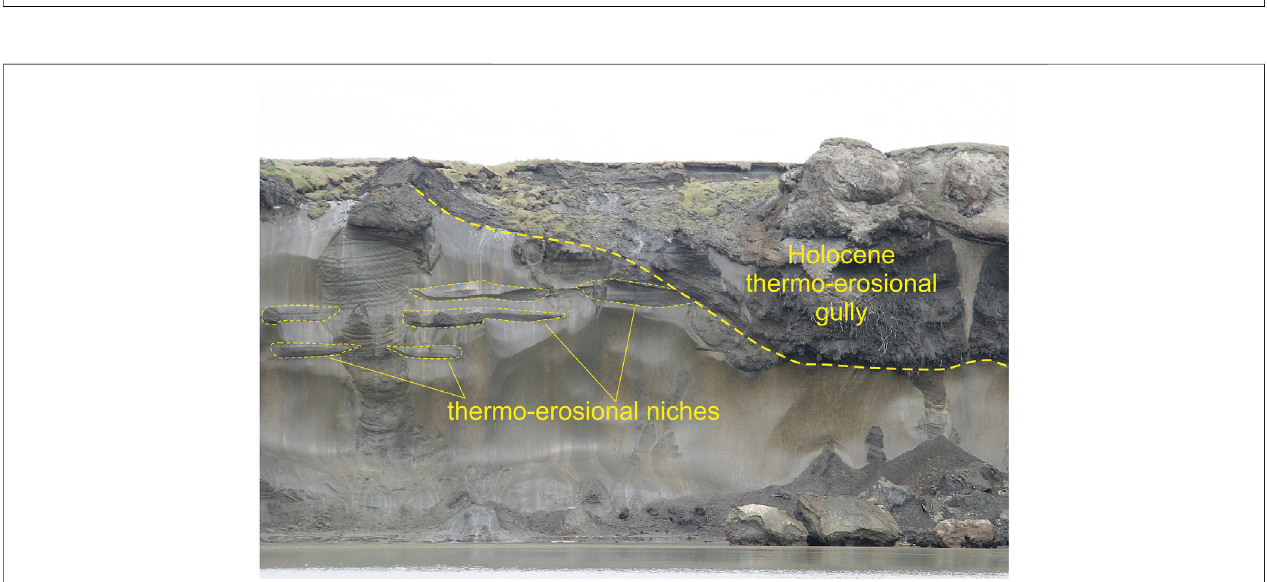
FIGURE 12 | Holocene thermo-erosional gully and niches in the yedoma Ice Complex.